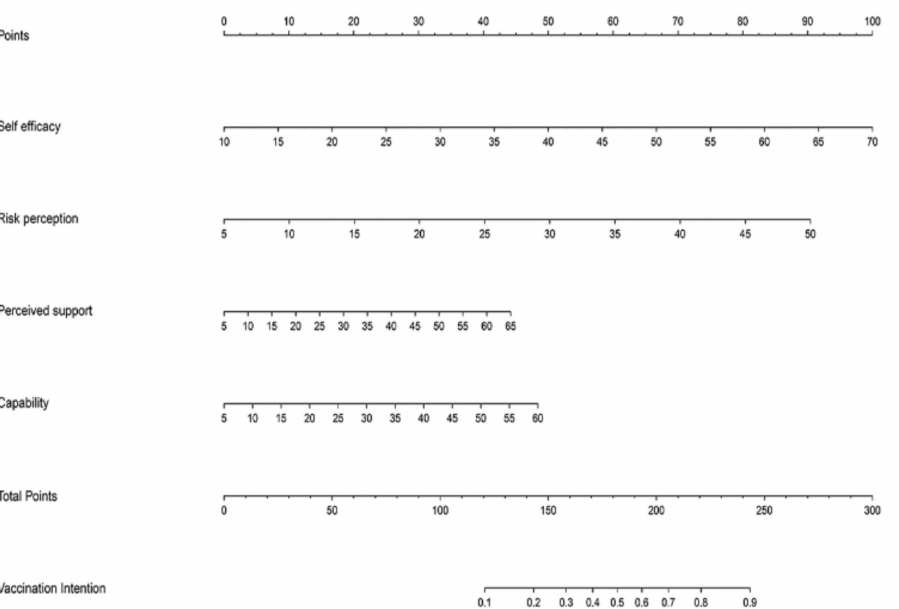
Figure 2. Developed nomogram for the COVID-19 vaccination intentions. Important features of self-efficacy, risk perception, perceived support and capability for the nomogram prediction model. .